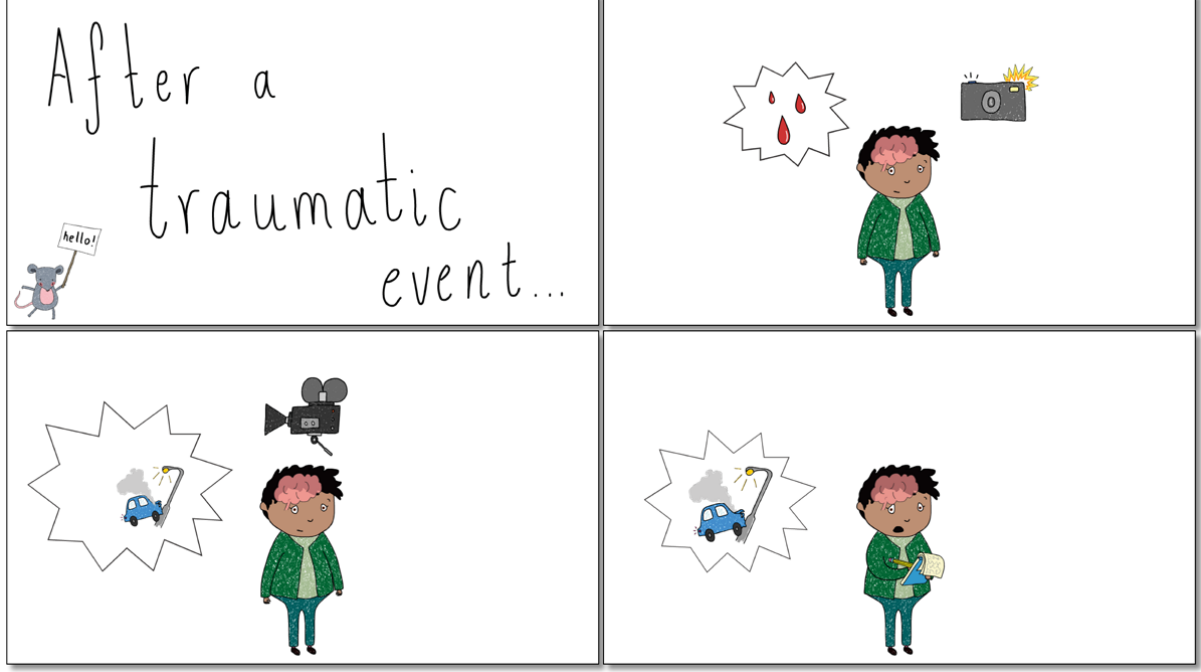
JMIR Ment Health 2021 | vol. 8 | iss. 2 | e23712 | p. 3https://mental.jmir.org/2021/2/e23712 (page number not for citation